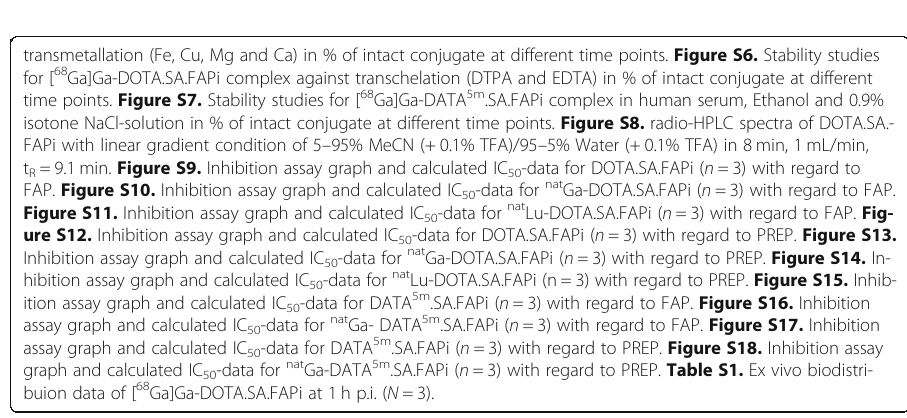
time points. Figure S7. Stability studies for [ 68 Ga]Ga-DATA 5m .SA.FAPi complex in human serum, Ethanol and 0.9% isotone NaCl-solution in % of intact conjugate at different time points. Figure S8. radio-HPLC spectra of DOTA.SA.- FAPi with linear gradient condition of 5 – 95% MeCN (+0.1% TFA)/95 – 5% Water (+ 0.1% TFA) in 8 min, 1 mL/min, t R = 9.1min. Figure S9. Inhibition assay graph and calculated IC 50 -data for DOTA.SA.FAPi ( n = 3) with regard to FAP. Figure S10. Inhibition assay graph and calculated IC 50 -data for nat Ga-DOTA.SA.FAPi ( n = 3) with regard to FAP. Figure S11. Inhibition assay graph and calculated IC 50 -data for nat Lu-DOTA.SA.FAPi ( n = 3) with regard to FAP. Fig- ure S12. Inhibition assay graph and calculated IC 50 -data for DOTA.SA.FAPi ( n = 3) with regard to PREP. Figure S13. Inhibition assay graph and calculated IC 50 -data for nat Ga-DOTA.SA.FAPi ( n = 3) with regard to PREP. Figure S14. In- hibition assay graph and calculated IC 50 -data for nat Lu-DOTA.SA.FAPi (n= 3) with regard to PREP. Figure S15. Inhib- ition assay graph and calculated IC 50 -data for DATA 5m .SA.FAPi ( n = 3) with regard to FAP. Figure S16. Inhibition assay graph and calculated IC 50 -data for nat Ga- DATA 5m .SA.FAPi ( n = 3) with regard to FAP. Figure S17. Inhibition assay graph and calculated IC 50 -data for DATA 5m .SA.FAPi ( n = 3) with regard to PREP. Figure S18. Inhibition assay graph and calculated IC 50 -data for nat Ga-DATA 5m .SA.FAPi ( n =3) with regard to PREP. Table S1. Ex vivo biodistri- buion data of [ 68 Ga]Ga-DOTA.SA.FAPi at 1h p.i. ( N = 3).